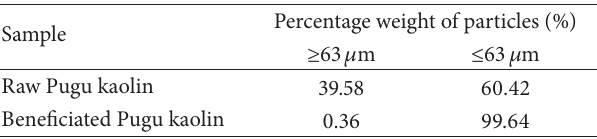
Table 1: Effect of beneficiation on the distribution of raw kaolinite particles.